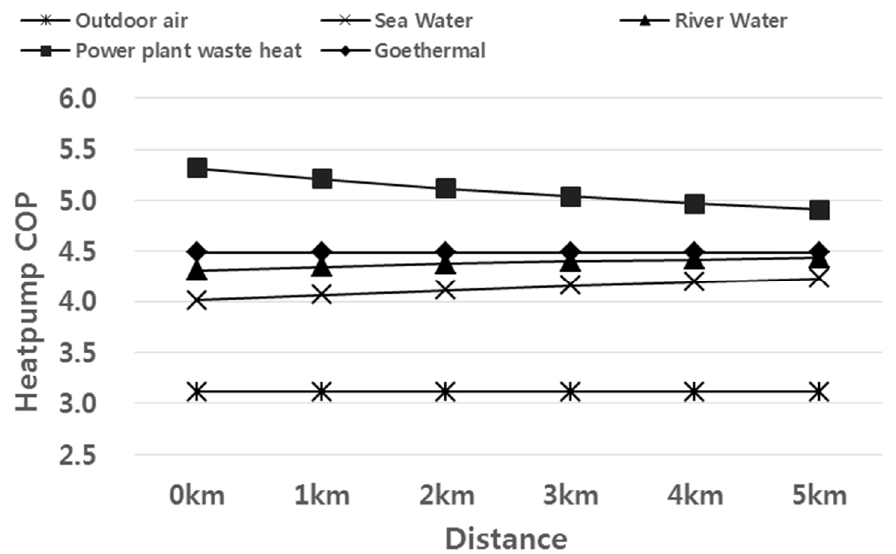
Figure 5. Average COP on the representative day of each heat source according to distance